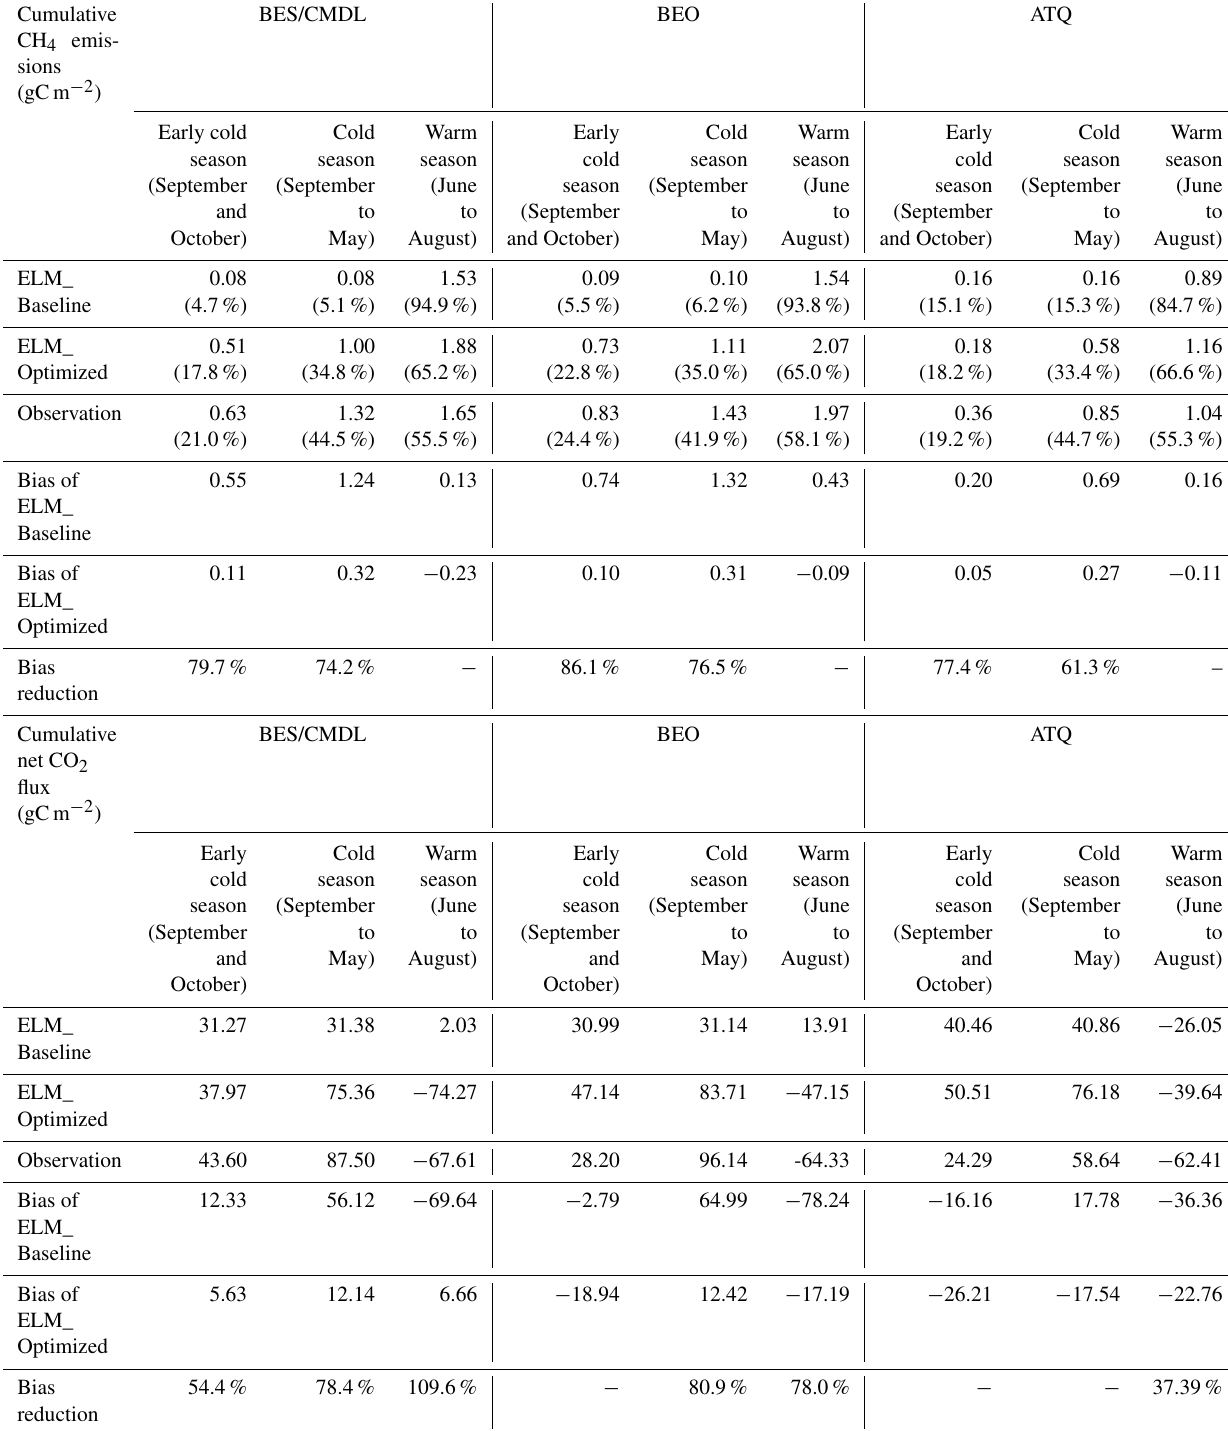
Table 4. Total CH 4 emissions and net CO 2 flux over three seasonal periods, including the early cold season, cold season, and the warm season. “ELM_Optimized” here means ELM_NewPC_Optimized (Table 2). The percentage of each seasonal total CH 4 emissions to the annual total is included in the